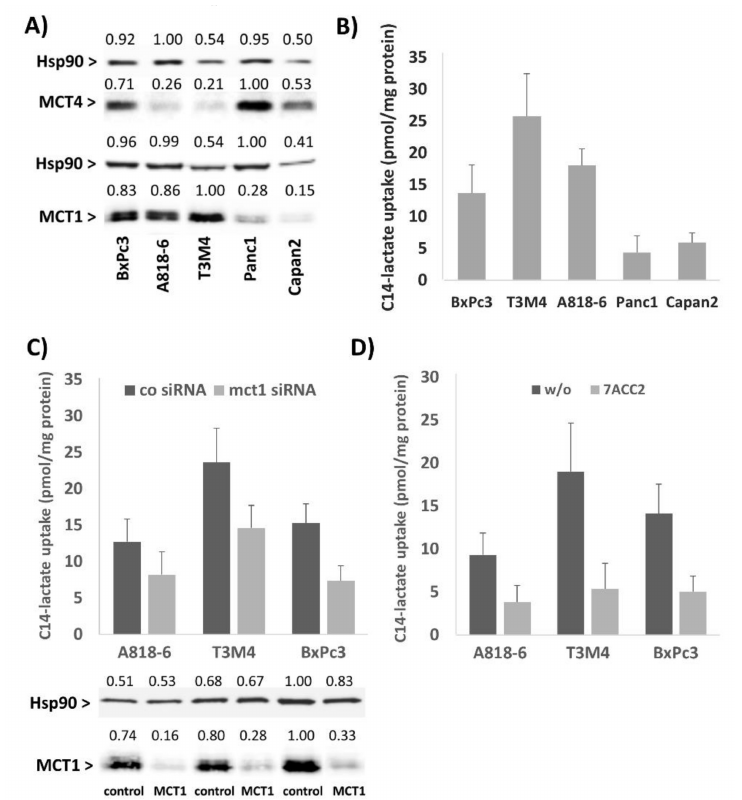
Figure 2. MCT1 expression in PDAC cells and its impact on cellular lactate uptake. ( A ) A818-6, BxPc3, T3M4, Panc1, and Capan2 cells were analyzed by Western blotting for the expression of MCT1 and MCT4. Heat shock protein 90 (Hsp90) expression was determined as loading control. A representative result from three independent experiments is shown. ( B ) A818-6, BxPc3, T3M4, Panc1, and Capan2 cells were submitted to C14-lactate uptake assay. Data express the specific incorporation of C14- lactate normalized to the amount of cellular protein and show the mean ± SD from three inde-pendent experiments. A818-6, BxPc3, and T3M4 cells were ( C ) treated with control or MCT1 siRNA for 48 h or ( D ) either left untreated (w / o) or treated with 20 µ M 7ACC2 for 2 h prior to submitting the cells to the C14-lactate uptake assay. Data show the mean ± SD from three independent experiments. The knock-down of MCT1 by siRNA was verified by Western blot shown at the bottom of panel ( C ). Numbers displayed above the images of the Western blots in ( A , C ) indicate the relative intensity of each